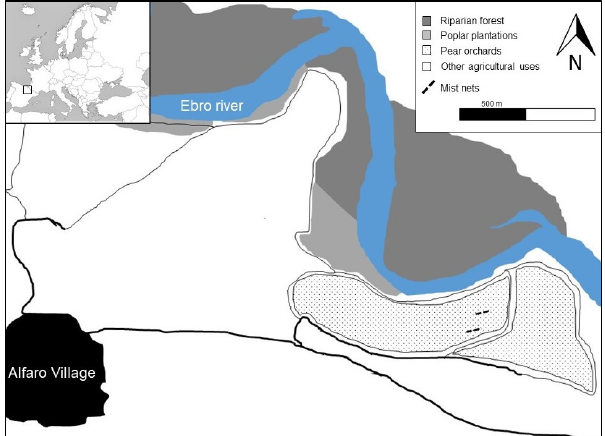
Figure 1. Study area and main land uses in the